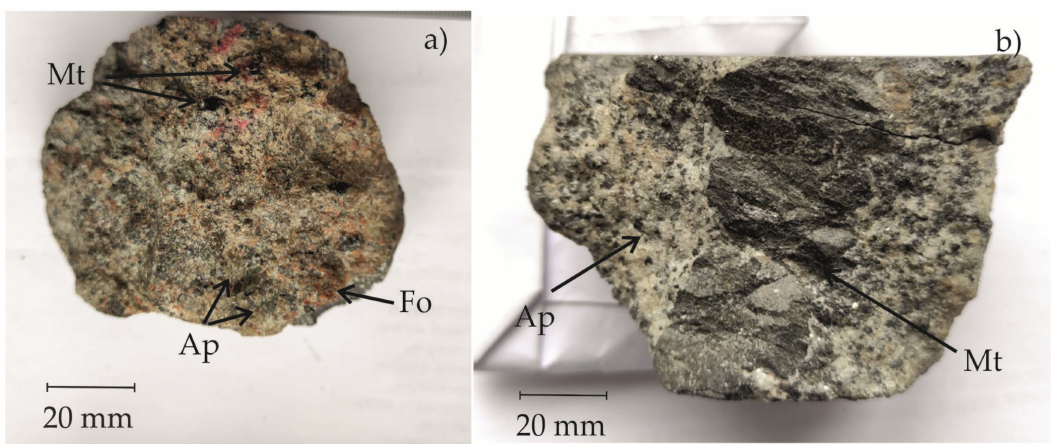
Figure 2. ( a ) baddeleyite-containing phoscorite. ( b ) pyrochlore containing phoscorite (Mt—magnetite; Ap—apatite;